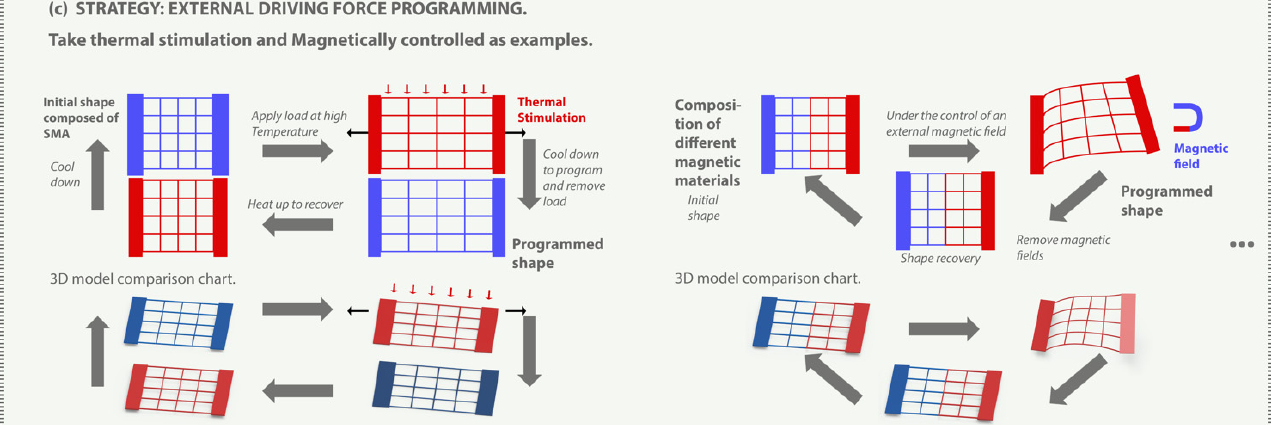
Figure 13. Examples of the programmable construction strategy based on cubic unit cells. ( a ) Pro- gramming of the geometrical parameters of the unit cell (e.g., forming a structure with different parameters by changing the length, width, and height, respectively, thus controlling the changing of the mechanical properties of the material). ( b ) Structural parameter programming (e.g., modulation of the mechanical properties of materials by means of fractal, hierarchical structural parameters). ( c ) External drive programming (e.g., adjustment of structural parameters by shape memory, magnetic control, thermal stimulation, and thus control the mechanical properties of the material from one state to another state).